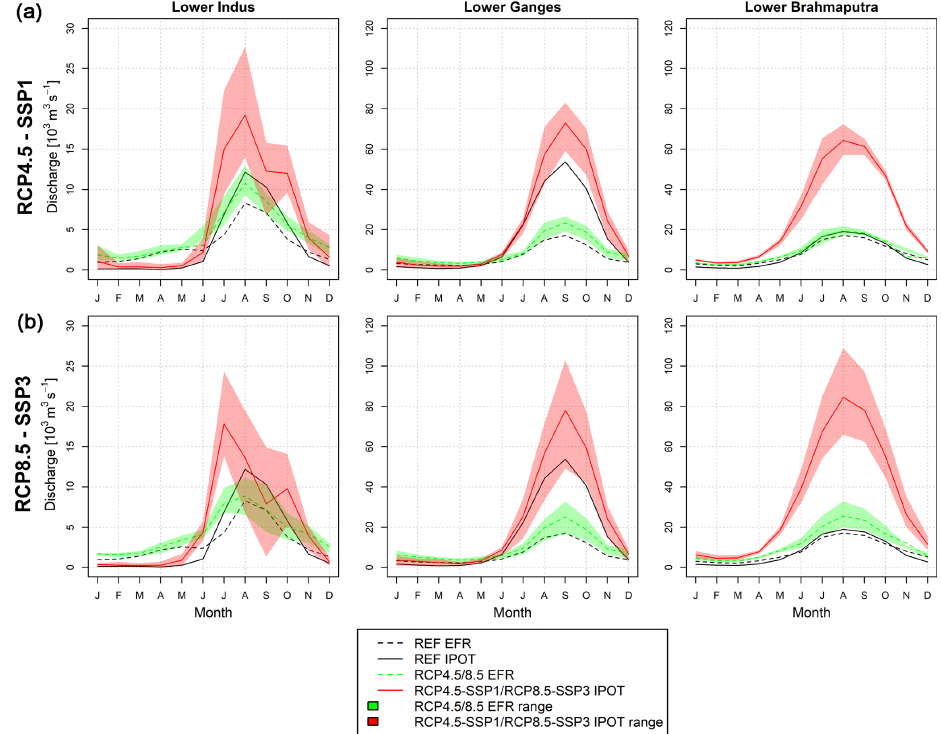
Figure 10. Monthly projected changes in the environmental flow requirements (EFRs) and anthropogenically influenced discharge (IPOT) at the outlets of the Indus, Ganges, and Brahmaputra rivers for RCP4.5-SSP1 (row a ) and RCP8.5-SSP3 (row b ). The projected changes are given for the end of the 21st century (EOC). The coloured bands represent the range of ensemble projections that are resulting from forcing the LPJmL model with the different climate models and SSP